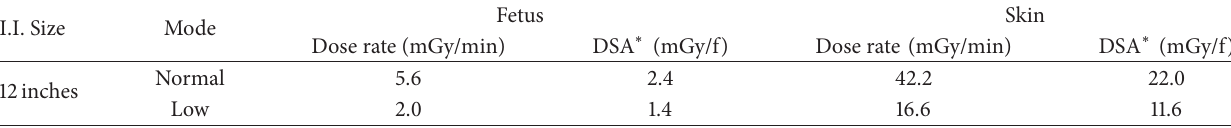
Table 3: Simulated results of radiation exposure with the GE-OEC C-arm in the operating